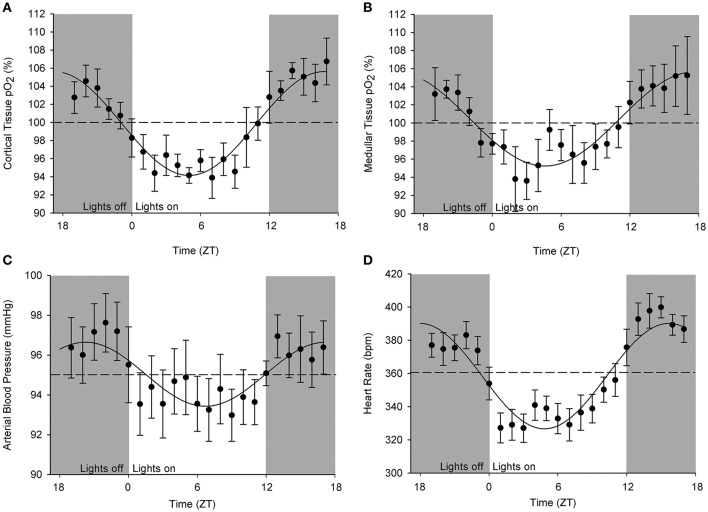
Cosinor analysis of the averaged circadian rhythms in kidney oxygenation, blood pressure, and heart rate. Data are plotted as hourly mean values ± SEM as recorded over 5 days in each rat relatively to the overall mean value (= MESOR, indicated by the dotted line). Note that different rats were used for obtaining oxygenation in (A) cortical and (B) medullary pO2 as well as for the (C) blood pressure. (D) Heart rate values were derived from blood pressure measurements. A significant circadian rhythm was assessed when the amplitude of the fitted curve was statistically >0, see Table 1.